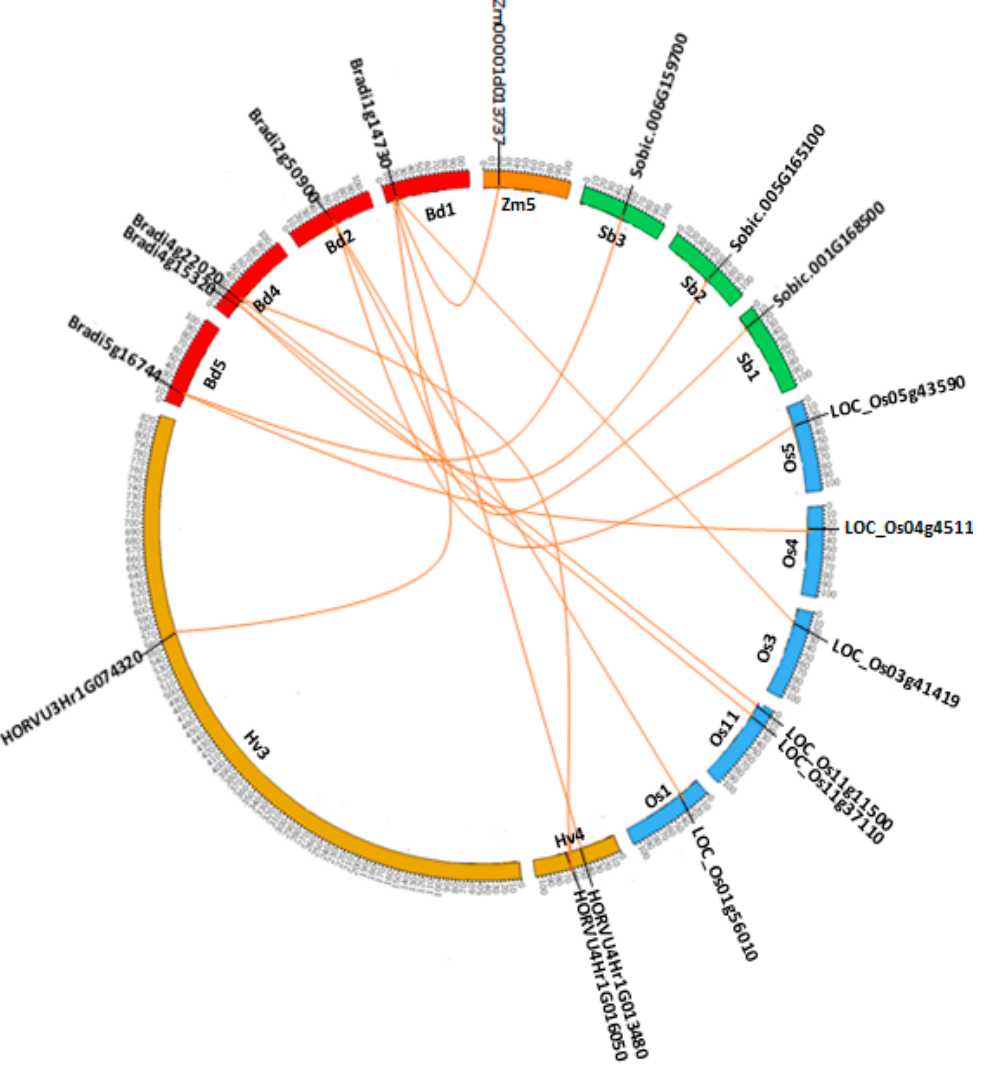
Figure 4. Syntenic block among serpin genes from Brachypodium , rice, sorghum, barley and maize. Chromosomes of Brachypodium (Bd), rice (Os), sorghum (Sb), barley (Hv) and maize (Zm) are shown in different colors and in circular form. The approximate position of the serpin genes is labeled with a short black line on the circle. Colored curves represented the syntenic relationships between Brachypodium , rice, sorghum, barley and maize serpin genes.